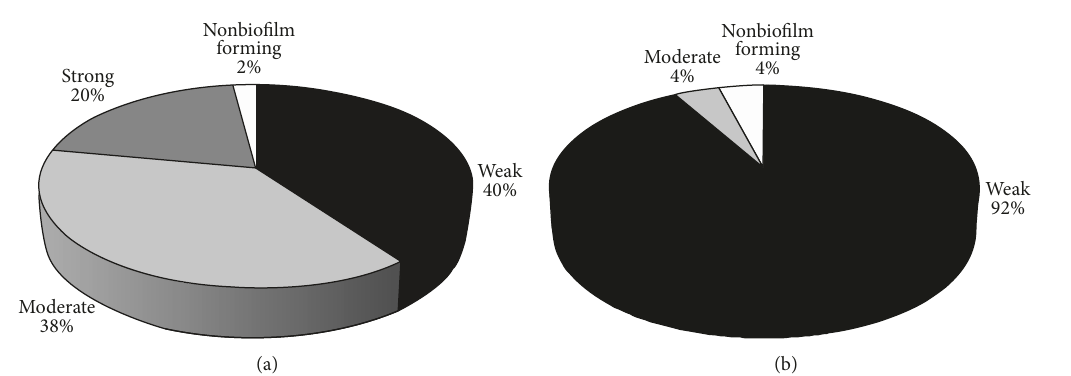
Figure 1: Categories of biofilm intensity of ESBLs and non-ESBLs producing K. pneumoniae . (a) ESBLs producers; (b) non-ESBLs producers.